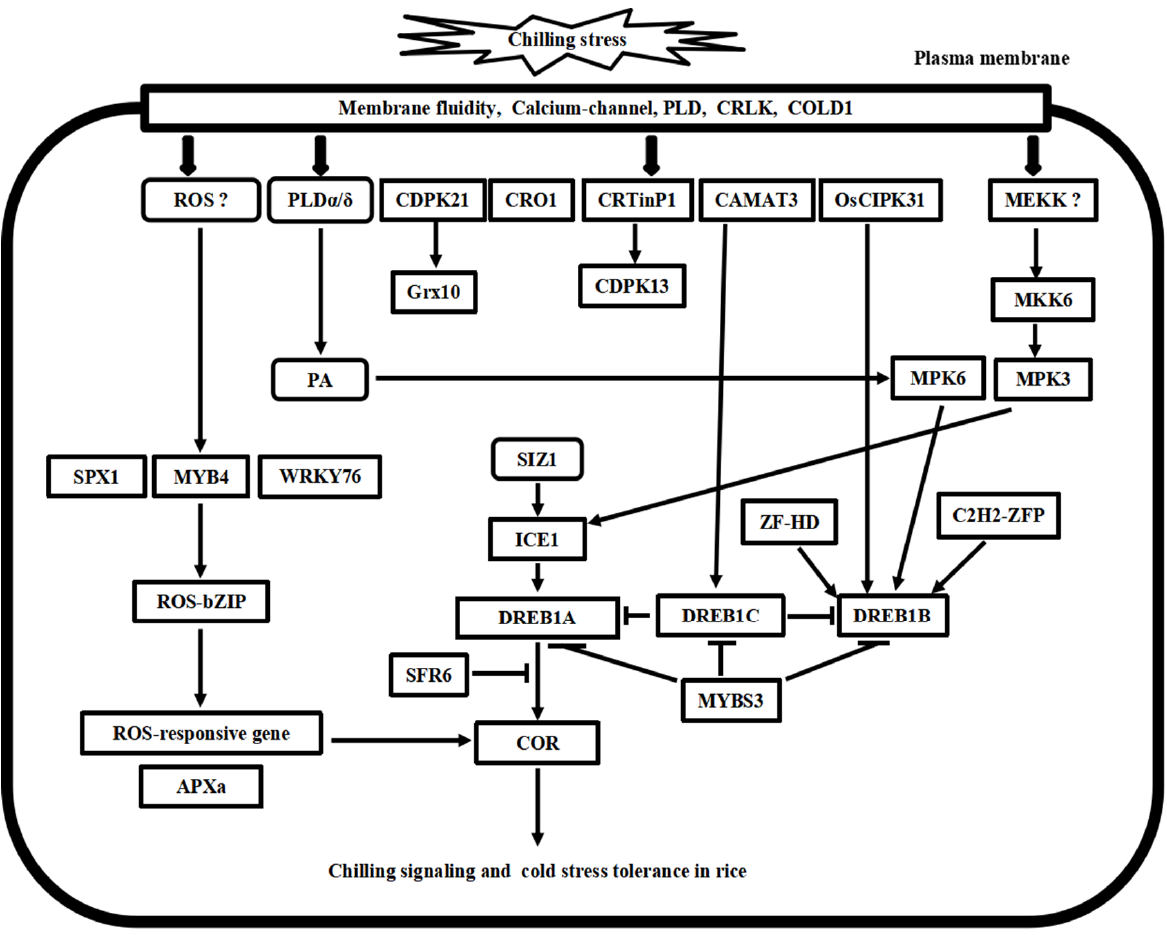
Figure 3. Putative model of chilling stress signaling networks toward cold stress tolerance in rice. There are at least four chilling stress signaling pathways in rice. MYB4-ROS-bZIP cascade is involved in the ROS signaling process. MKK6-MP3 cascade and phospholipid signaling work with calcium signaling concomitantly in chilling stress signaling in rice. ICE1- DREB transcriptional regulatory cascade is conserved in the Arabidopsis and rice. Furthermore, these pathways’ upstream and downstream signal transducer proteins play cooperative and regulatory roles in cold stress tolerance in rice.